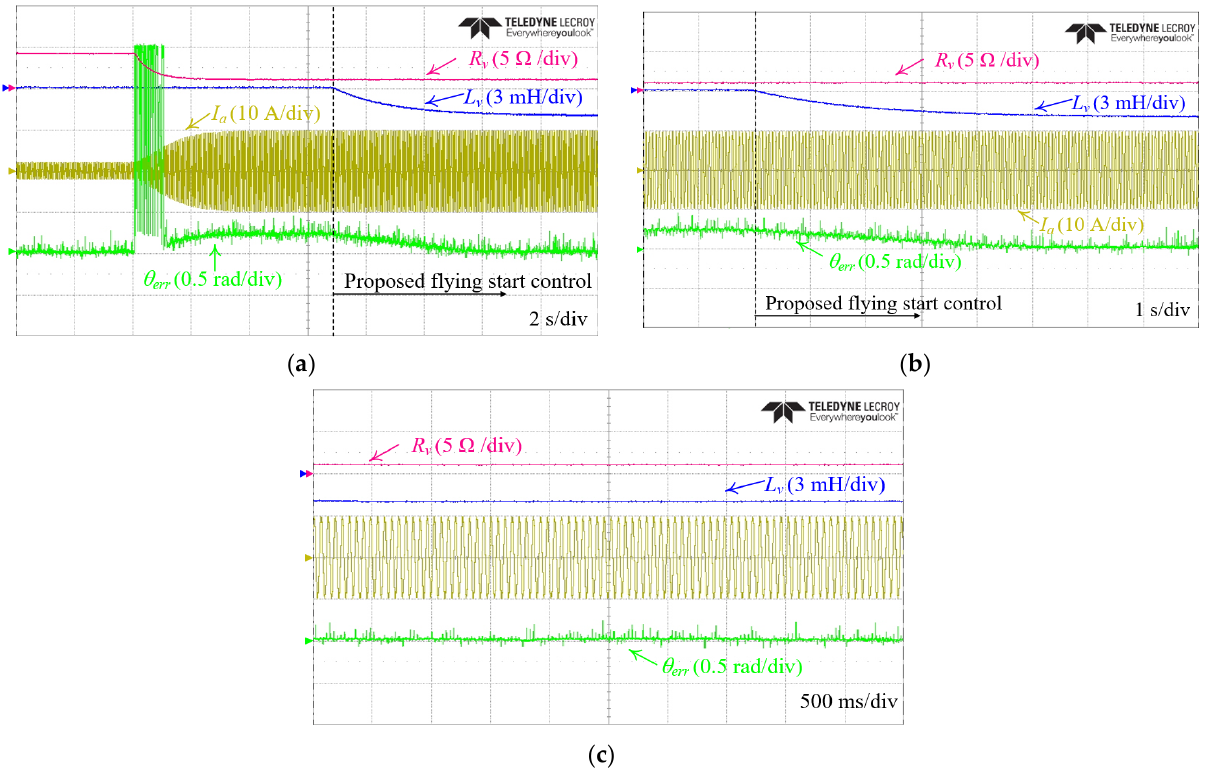
Figure 17. Experimental results of the proposed flying start method and its position estimation error at 500 rpm. ( a ) R v , L v , I a , and θ err ; ( b ) magnified waveform of ( a ); and ( c ) the steady state of the proposed flying start method.